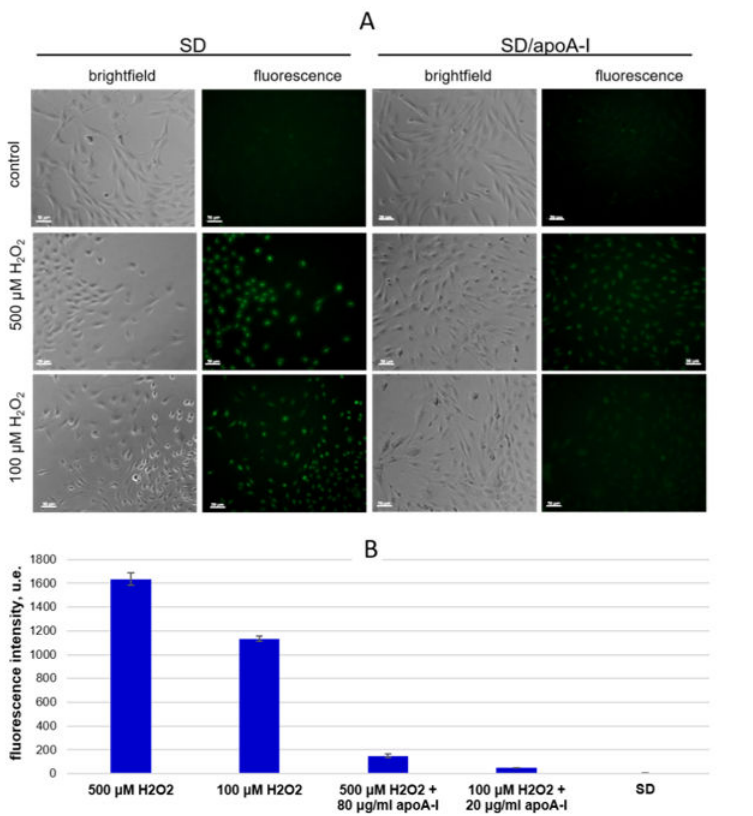
Figure 6. ApoA-I reduces intracellular ROS species was induced by 100 µ M and 500 µ M H 2 O 2 . CellROX ® Green reagent was used as an intracellular reactive oxygen species (ROS) detector. ( A ) Brightfield and green fluorescent channel micrographs of MSCs, × 20, scale bar 50 µ m. ( B ) Fluorescence Intensity calculated using software Cell Activision R1.03.01. The results are presented as arbitrary fluorescence units